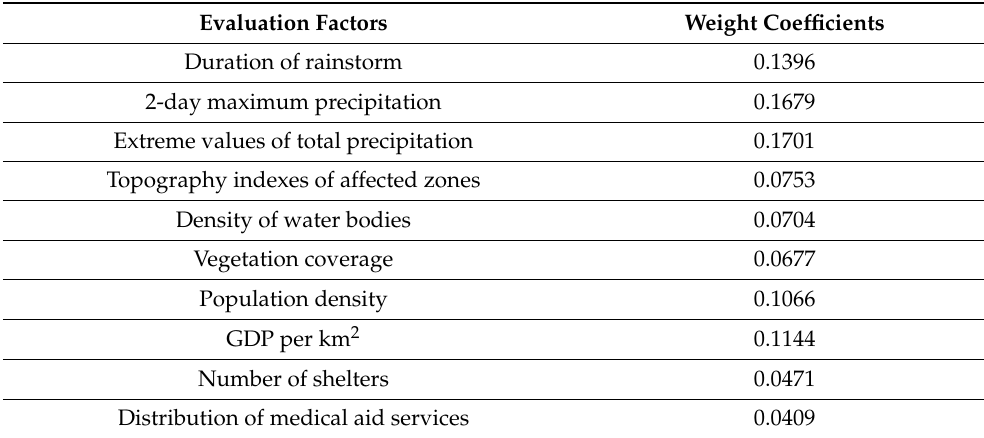
Table 1. Weight coefficients of evaluation factors for disaster losses caused by flash